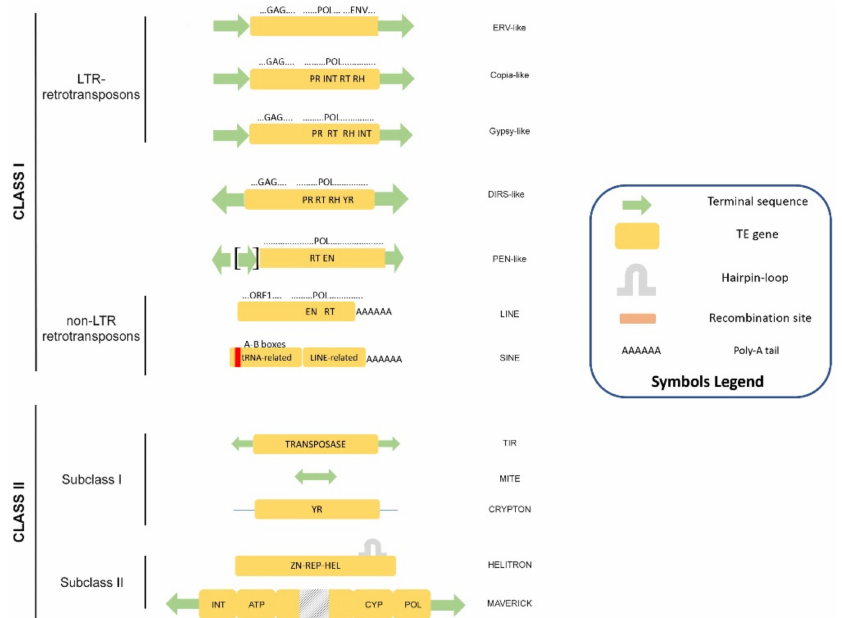
Figure 1. Classification of eukaryotic transposable elements according to Wicker et al. [15]. The structure and the coding potential are depicted for each of the superfamilies. Symbols are explained in the legend